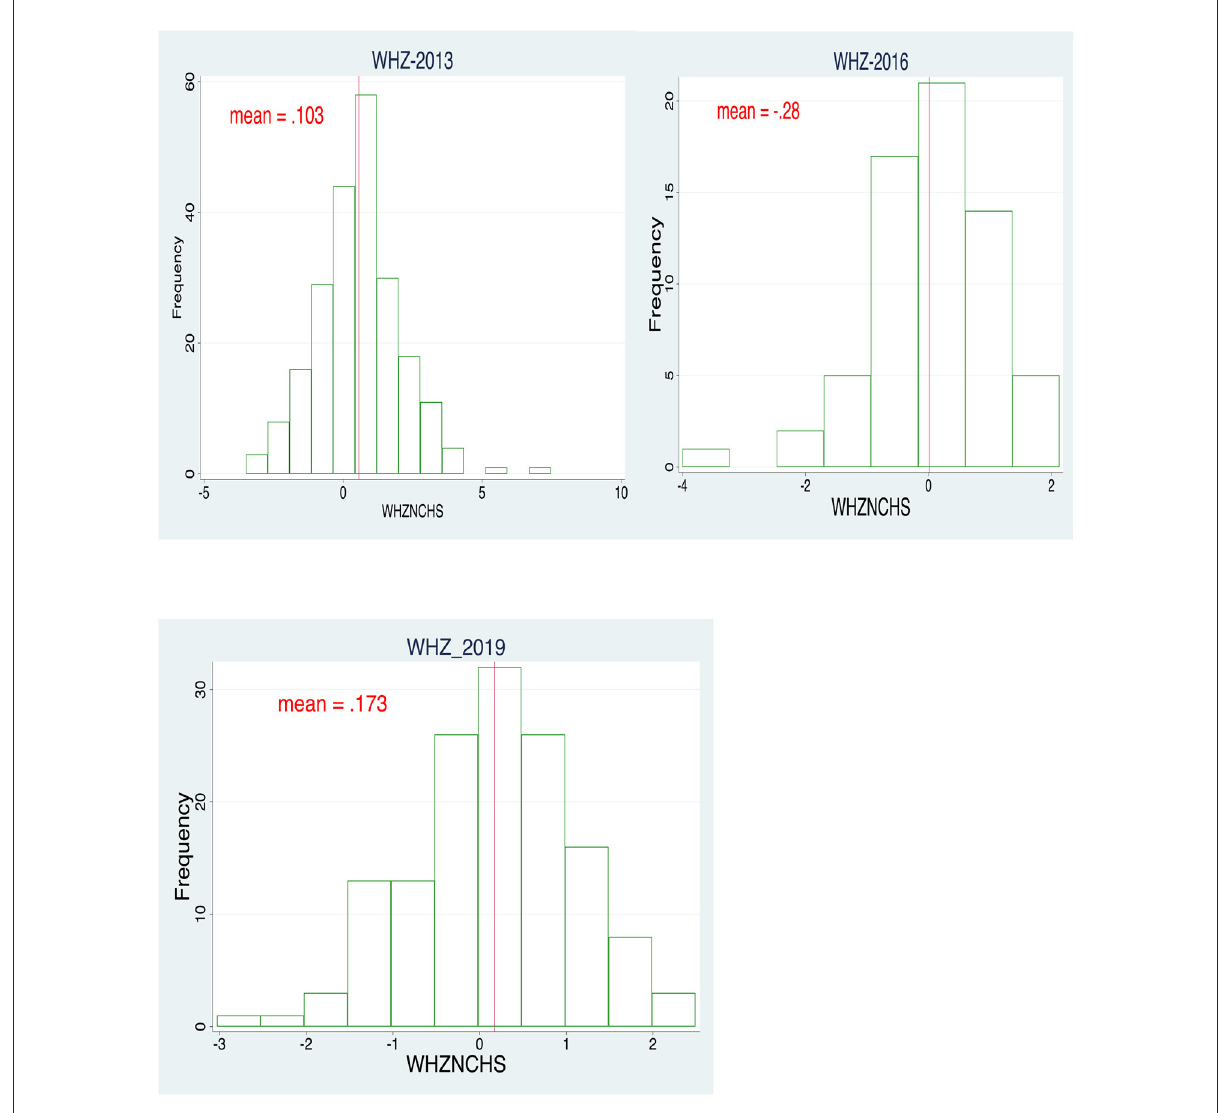
FIGURE1 Wasting levels of children under-5 years in 2013,2016, and